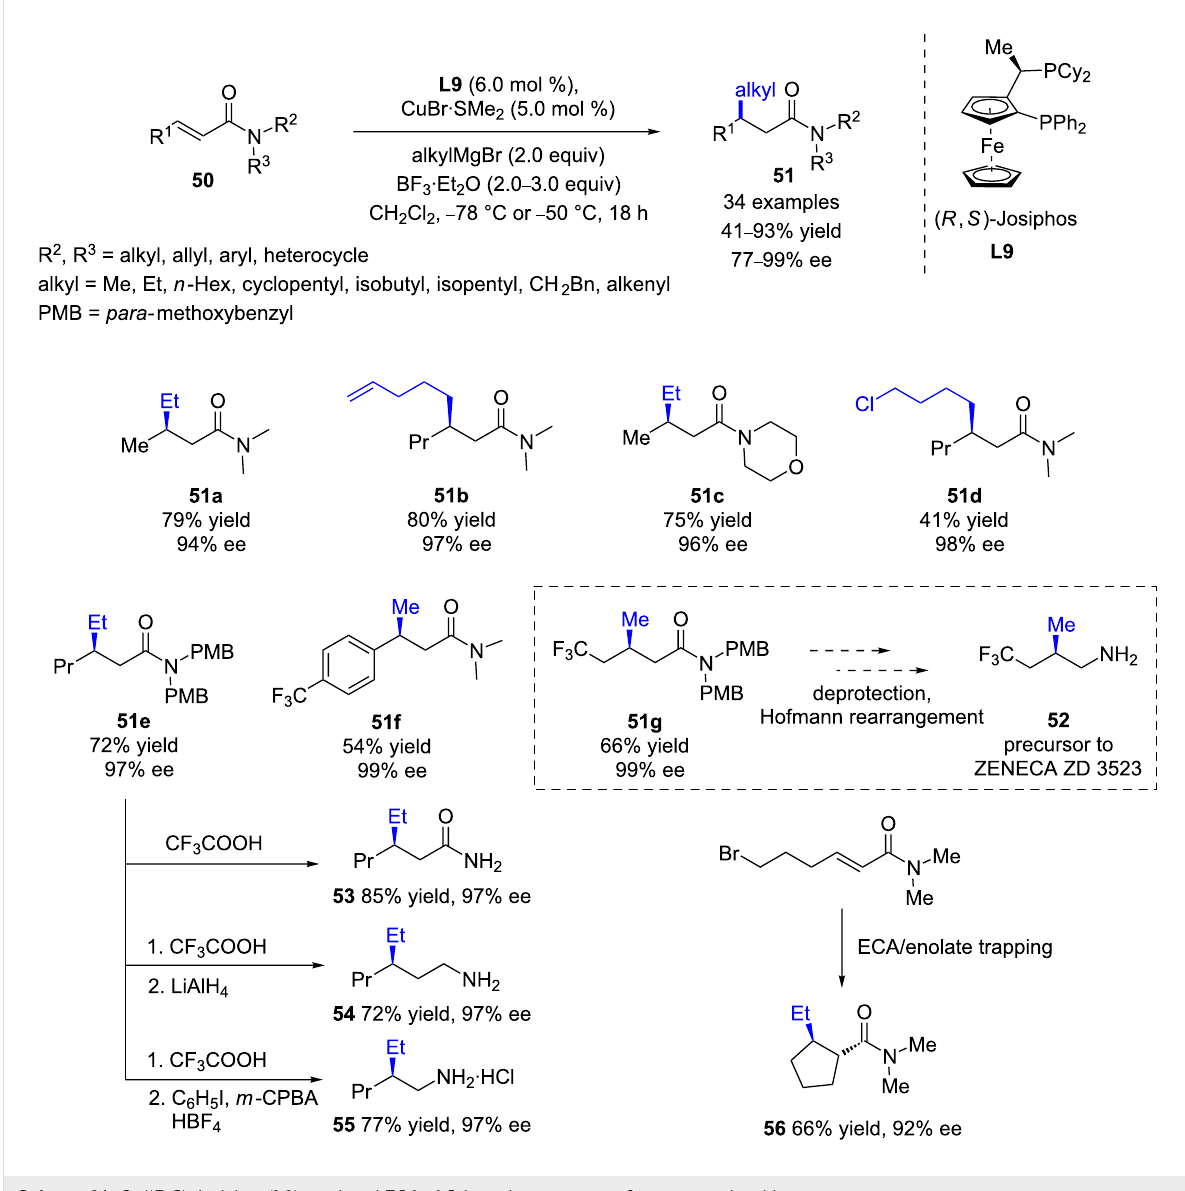
Scheme 21: Cu/( R , S )-Josiphos ( L9 )-catalyzed ECA of Grignard reagents to α , β -unsaturated